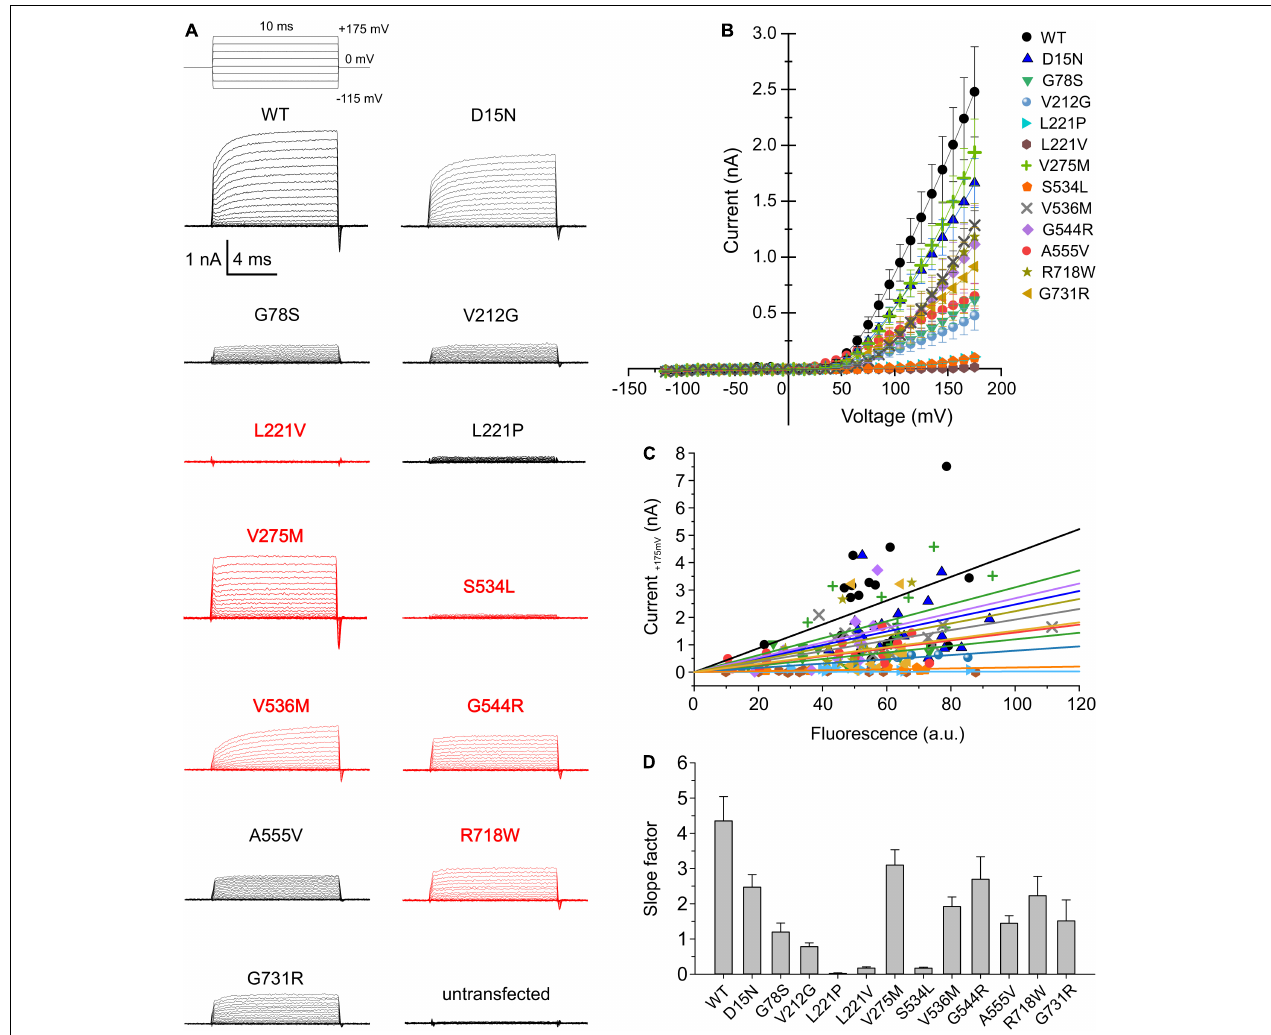
FIGURE 2 | Whole-cell patch clamp analysis of WT and mutant ClC-4 currents. (A) Test pulse protocol and representative whole-cell recordings from HEK293T cells expressing WT or mutant ClC-4. (B) Steady-state current–voltage relationships for WT and mutant ClC-4 variants, the steady-state current represent the mean value ± s.e.m. (C) Current-fluorescence plots for WT and mutant ClC-4. Solid lines represent linear fits (a.u. denotes arbitrary units). (D) Slope factors obtained from linear fits to the current-fluorescence plots shown in (C) , ClC-4 mutants were compared with WT using one-way analysis of variance (with Tukey’s HSD post hoc testing). (WT, n = 19; D15N, n = 19; G78S, n = 10; V212G, n = 10; L221P, n = 12; L221V, n = 12; V275M, n = 15; S534L, n = 7; V536M, n = 12; G544R, n = 10; A555V, n = 15; R718W, n = 12; and G731R, n = 11). Data were obtained from four or five independent transfections.